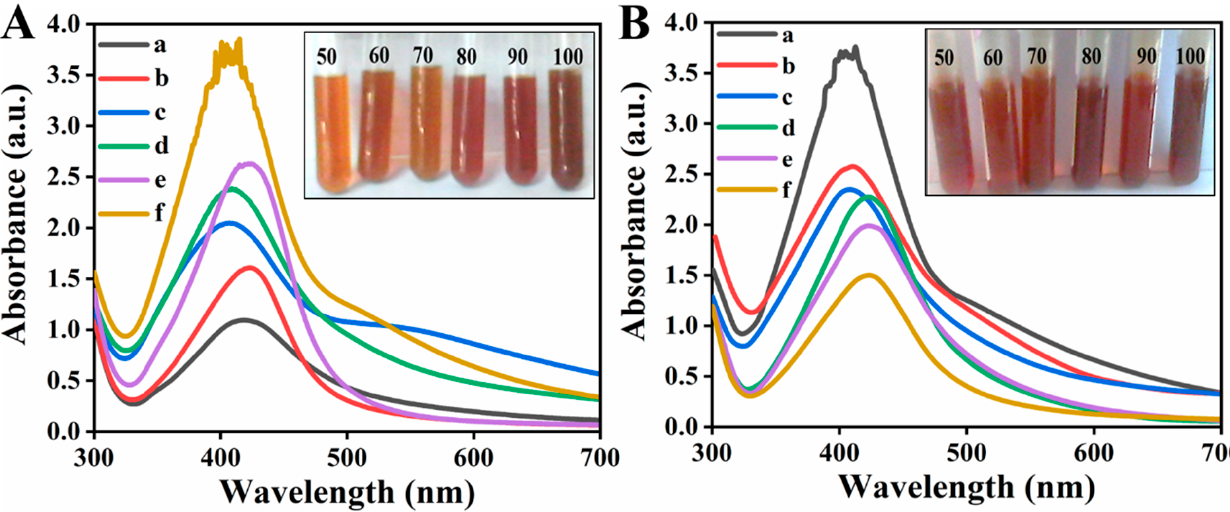
Figure 5. UV spectra of ( A ) L-Ag-Nps ( B ) R-Ag-Nps at different temperature (a) 50 °C, (b) 60 °C, (c) 70 °C, (d) 80 °C, (e) 90 °C and (f) 100 °C.